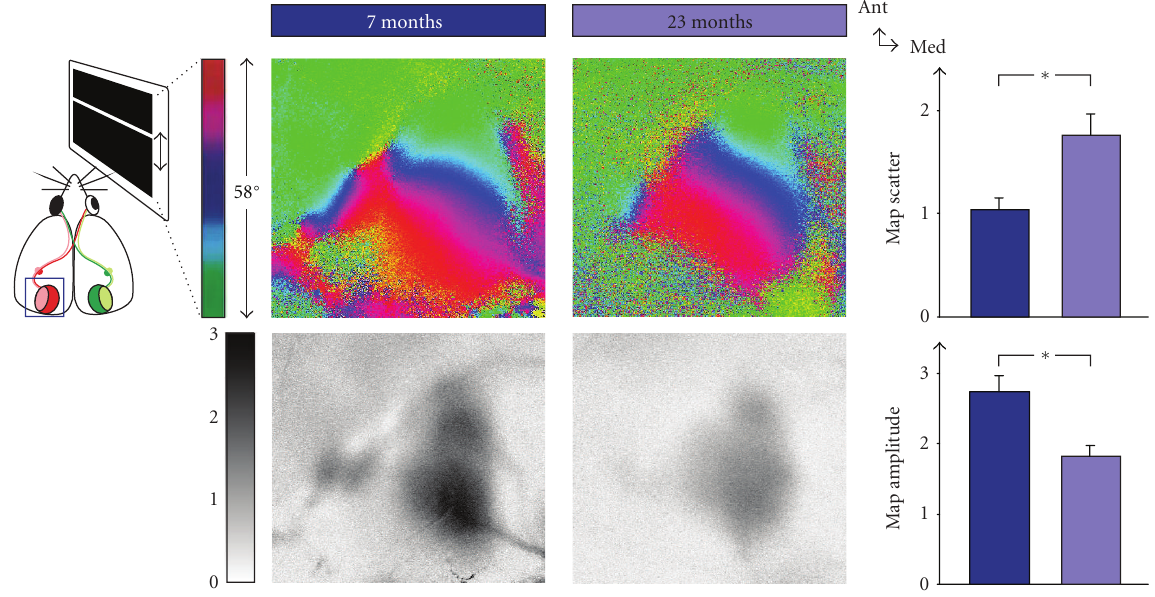
Figure 8: Visual cortical maps deteriorate in old age. Retinotopic phase maps (colour-coded according to scheme on the top left) and corresponding activity maps (coded according to grey scale on the left) are shown for mice of seven and 23 months. Map scatter increases in old mice, while the amplitude decreases. Scale bar is 1 mm and applies to all panels showing